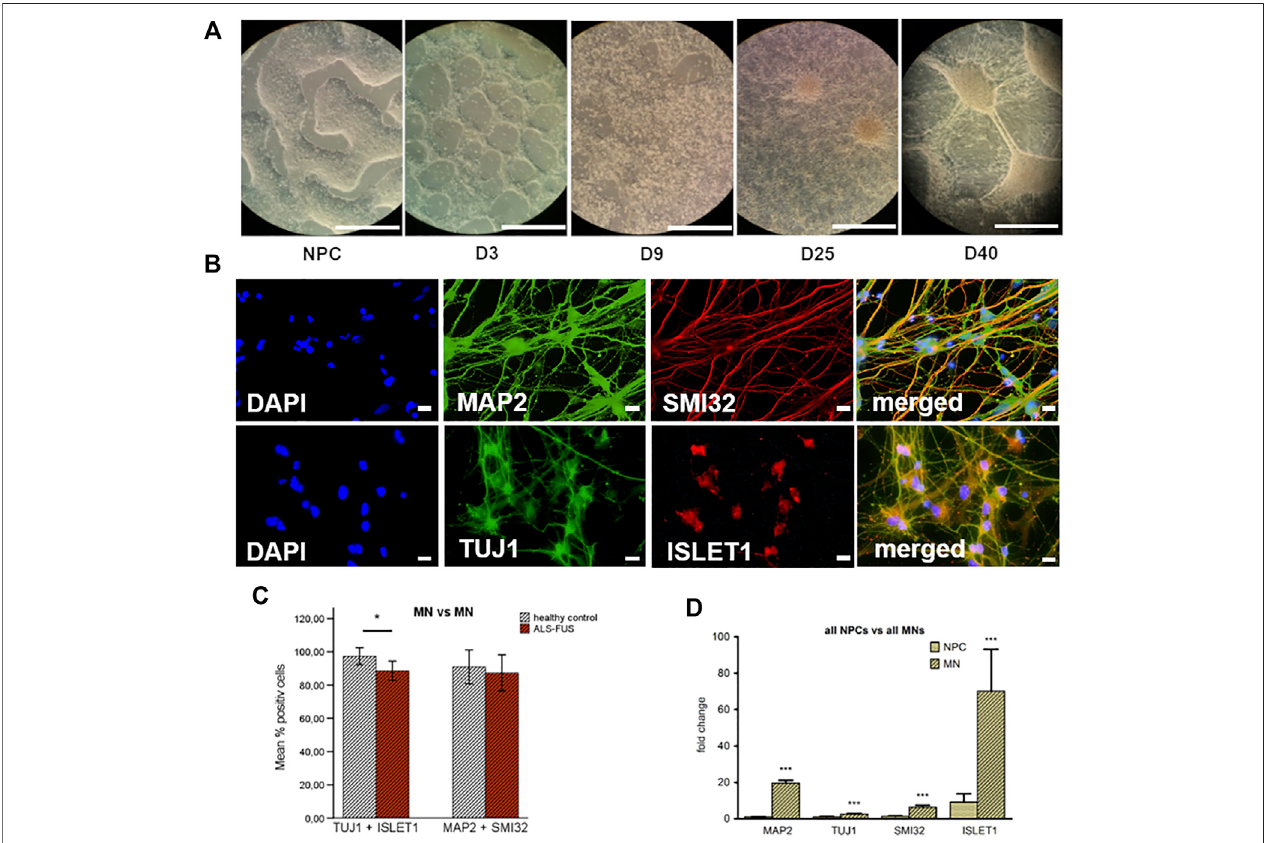
FIGURE 1 | Motor neuron differentiation, (A) After differentiation day 9, extensive branching and increased interconnectivity of cells was observed in our colonies, on day 40 mature motor neurons showed complex neurite outgrowth and increased soma areas, (B) Immuno fl uorescence: mature MNs stained positive for neuronal- and MN-speci fi c markers, 88% of all counted cells stained positive for neuronal marker TUJ1 and MN-associated marker ISLET1 , 89% of all counted cells stained positive for neuronal marker MAP2 and MN-associated neuro fi lament marker SMI32 , (C) Quantitative analysis of the motor neuron populations in neuronal cell culture at D40. Control MNs showed signi fi cantly higher count of cells staining positive for TUJ1 + ISLET1 than FUS mutant MNs, but no signi fi cant difference of cells staining for MAP2 + SMI32 , (D) Quantitative real-time PCR con fi rmed immuno fl uorescence results. MNs expressed signi fi cantly more neuronal markers ( TUJ1 / MAP2 ) andMN-speci fi cmarkers( SMI32 / ISLET1 ).Graphsshowfoldchangeofexpressioncomparedtoreferencegene GAPDH or PPIA .Statisticalinferencesweredrawnfrom unpaired t -test or in case of non-normal distribution from Mann-Whitney test and illustrated as mean ± SEM. Results were regarded as statistically signi fi cant with *** p